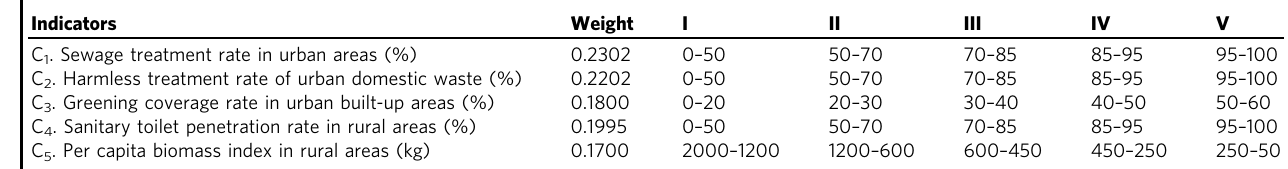
Table 1 Index system of quality evaluation of urban – rural human settlements and the grading standards.